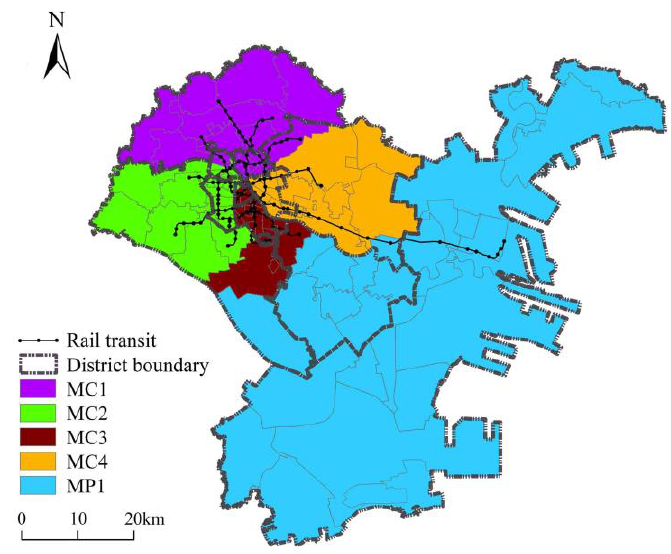
Figure 7. The commuting communities in Tianjin metropolitan area. Table 3. The number of residents and jobs of commuting communities in Tianjin metropolitan area.